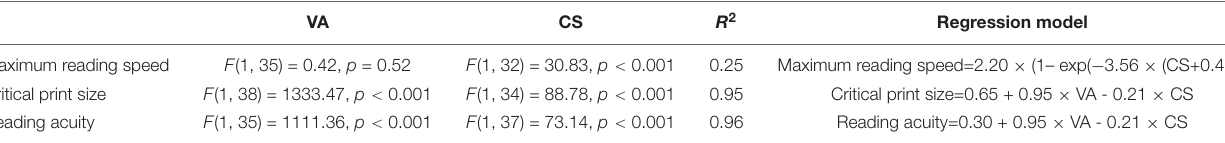
FIGURE 4 | The impact of simulated acuity and contrast sensitivity reduction on the reading performance of the YN group. (A) Maximum reading speed as a function of the expected CS. The red arrow represents the critical CS for a maximum reading speed of at least 90% of the maximum reading speed for normal vision (asymptote). (B) Critical print size as a function of the expected VA. (C) Reading acuity as a function of the expected VA. In all three plots the circles represent the group average of each simulated low vision condition, and the error bars represent standard errors. TABLE 3 | Regression models on maximum reading speed, critical print size, and reading acuity with VA and CS as predictors. VA CS R 2 Regression